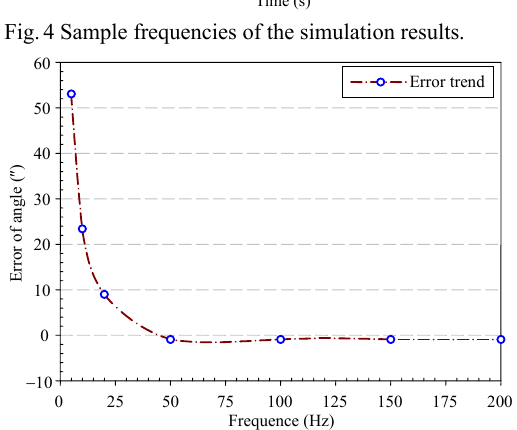
Fig. 5 Error with sampling frequencies of north